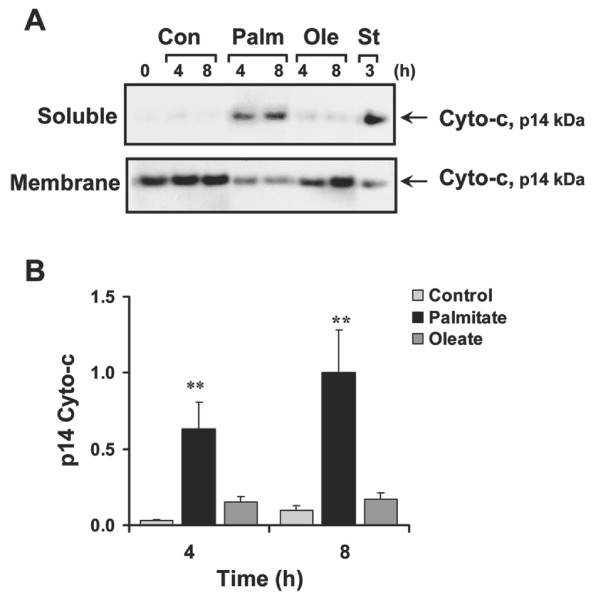
Palmitate induces translocation of cytochrome-c in cultured HMC. (A) Cells treated with control (Con, i.e., albumin alone), palmitate (Palm, 0.4 mM), oleate (Ole, 0.4 mM), or staurosporine (St, 1 μM) for the times indicated. HMC were then rapidly separated into soluble cytosolic and insoluble membrane fractions. The amount of cytochrome-c (Cyto-C) was determined by Western blotting. Equivalent amounts of total protein were present across all lanes of the cytoplasmic and membrane fractions, but the membrane fractions contained approximately 3 times more protein than the corresponding lane in the cytoplasmic fraction. (B) Densitometric analysis of cytoplasmic p14 kDa cytochrome-c from 3 independent experiments. Data are mean ± SEM. **, P < 0.01 by ANOVA versus control and oleate alone.